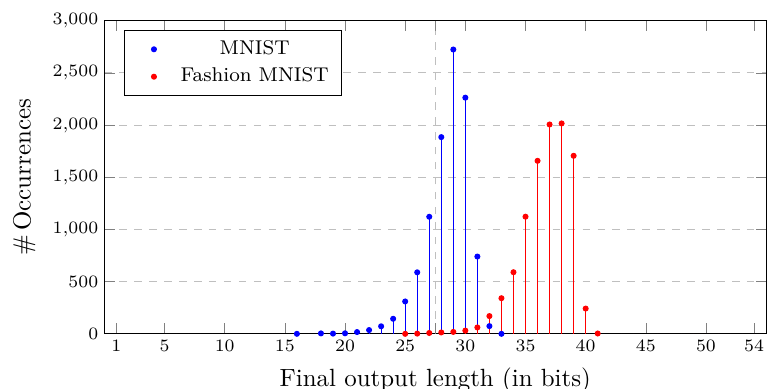
Figure 7: Distributions of the output bit-lengths for the MNIST and Fashion MNIST datasets. The diagrams are plotted from 10,000 images. The mean lengths are 29 and 37 bits for MNIST and Fashion MNIST, respectively. Discrete logarithms to the left of the vertical dashed line are found directly in the precomputed table with B Table 5: Performance comparison for the ML classification on the encrypted MNIST and Fashion MNIST datasets. Timings (in seconds) include all 10 FE-QF decryptions. Implementation Platform